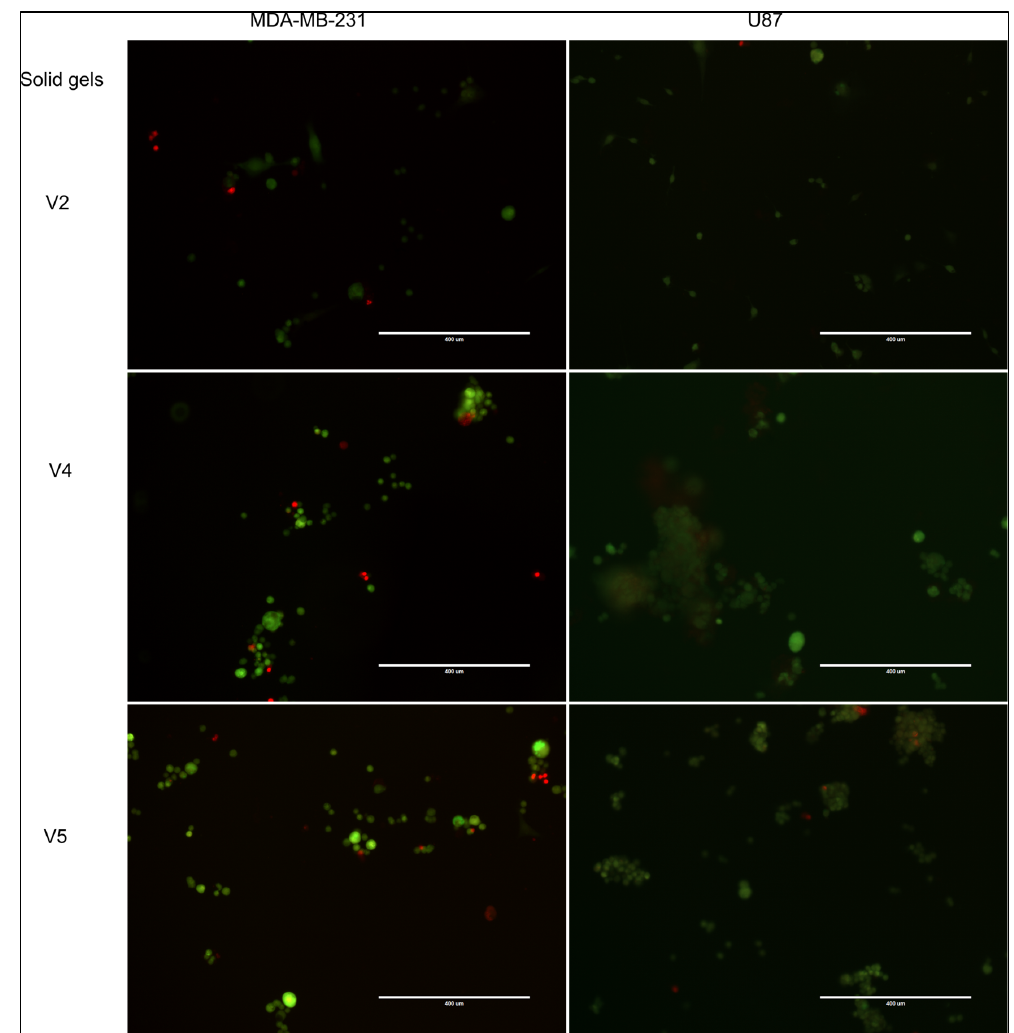
Figure 5. Viability of cells within spheroids was tested using live/dead fluorescent assay. Living cells are highlighted in green with fluorescein and dead cells in red with propidium iodide. 10× magnification. Scale bar 400 μ m.